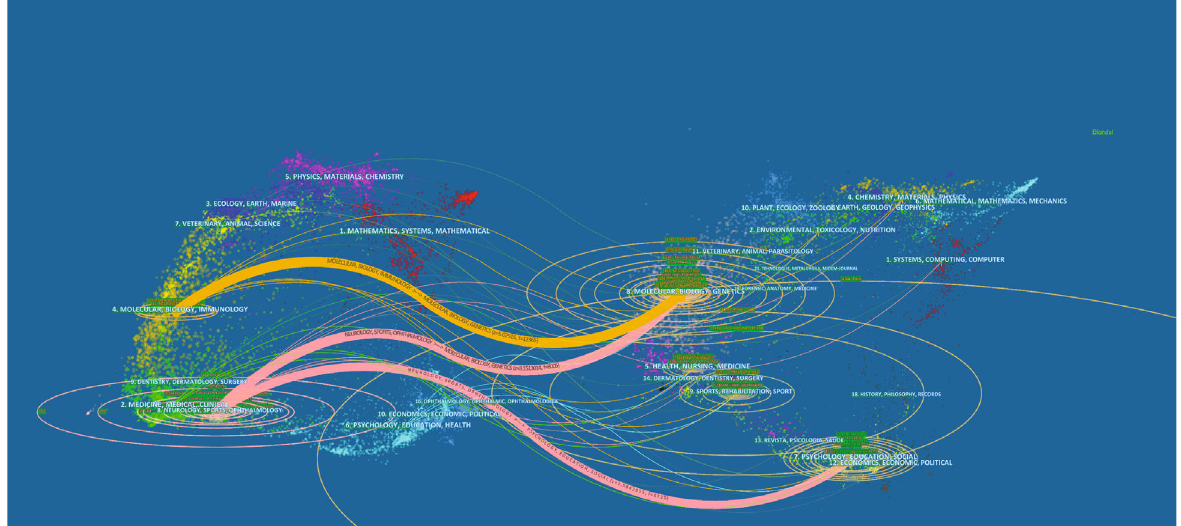
Figure 3: The dual-map overlay of journals related to pain after spinal cord injury.